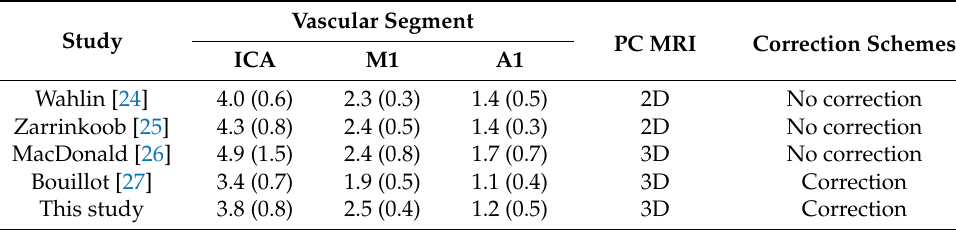
Table 1. Comparison of previously reported data of mean flow rates calculated with PC MRI in healthy